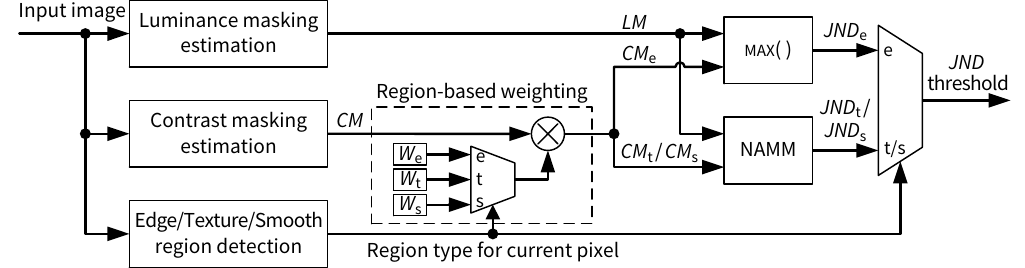
Figure 4. Block diagram of the proposed JND